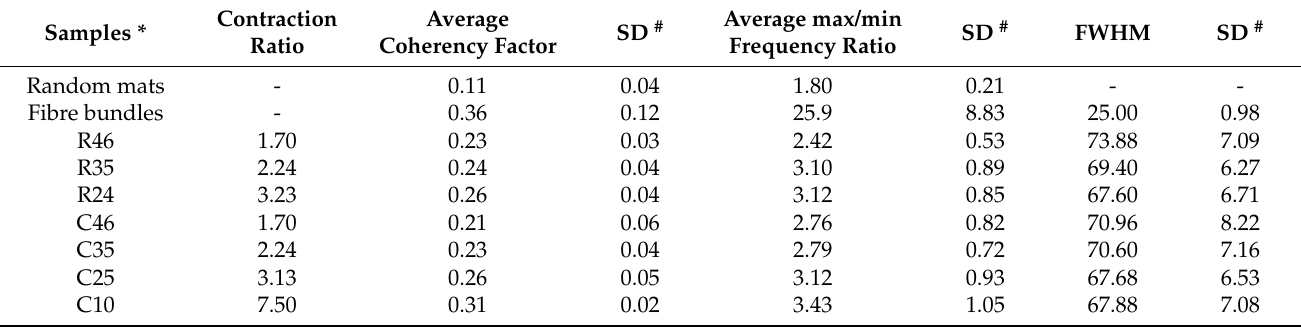
Table 4. Coherency factors generated by the OrientationJ plugin, the calculated frequency ratio, and full width at half maximum (FWHM) of the fibre orientation distribution profiles.